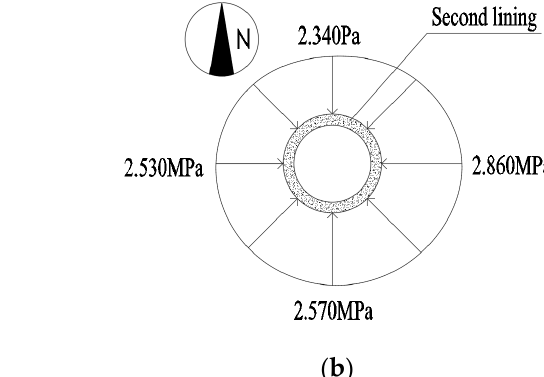
Figure 19. S1ZK0 + 735 m section MIDAS-GTS load loading plan. ( a ) Uniform pressure; ( b ) Non- uniform pressure.